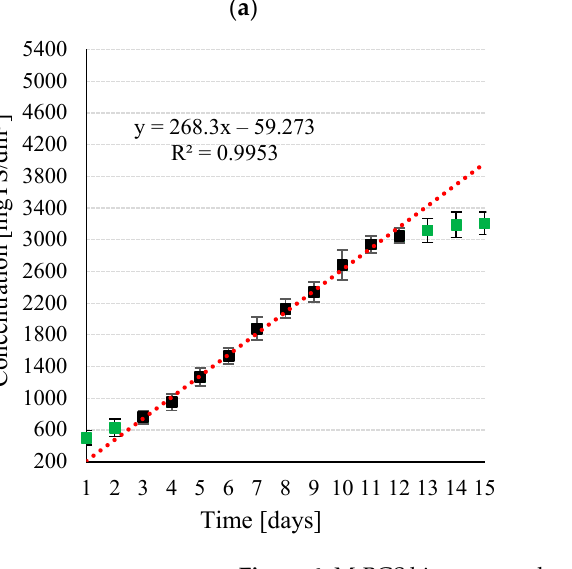
Figure 7. M-BGS biomass production in phases: ( a ) phase 3 (days 31–45) and ( b ) phase 4 (days 46– 60) of the H-PBR operation. Through days 31 to 43, the microalgae + AS microbes biomass grew from 540 ± 103 mgTS/dm 3 to 3990 ± 422 mgTS/dm 3 , which translates to a growth rate of 317 ± 29 mgTS/dm 3 ·d. The growth rate subsequently tapered off, with no further significant in- creases. The final concentration at the end of the phase was 4250 ± 432 mgTS/dm 3 (Figure 7a). Throughout days 46 to 60, the microbial community entered its final stage of structure and population, and saw no further changes over the remaining period of operation. The mature M-BGS biomass grew at its highest rate—423 ± 39 mgTS/dm 3 ·d. No lag phase was